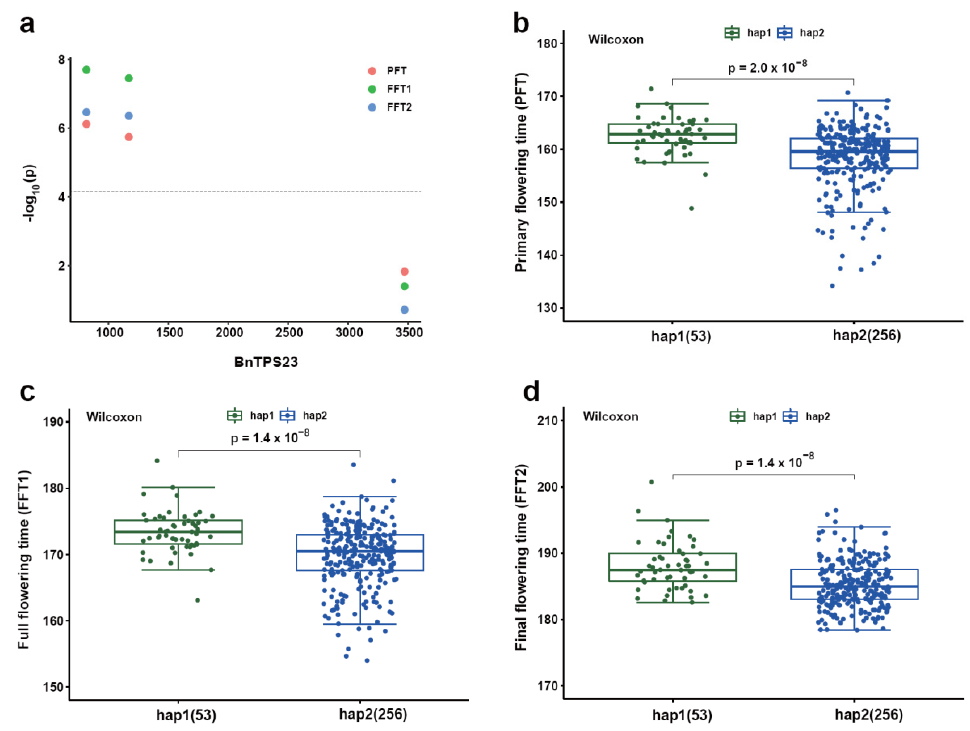
Figure 8. The association mapping analysis of BnTPS23 in the B. napus population. ( a ) Manhattan plot of BnTPS23 with primary flowering time (PFT), full flowering time (FFT1), and final flowering time (FFT2). ( b – d ) The haplotype analysis of BnTPS23 for PFT, FFT1, and FFT2 based on the significant associated SNP.